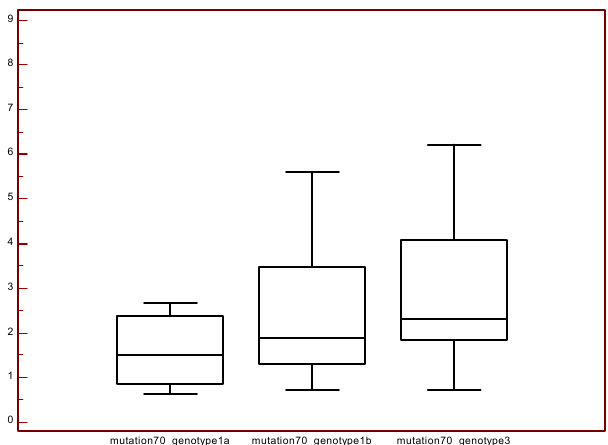
Figure 1. Boxplots for each genotype and mutation 70 according to HOMA values for each patient. Mutation70_genotype1a: Median, 1.501; Minimum, 0.6321; Maximum, 2.669. Mutation70_genotype1b: Median, 1.881; Minimum, 0.7246; Maximum, 6.793. Mutation70_genotype3: Median, 2.312; Minimum, 0.7104; Maximum, 8.880.